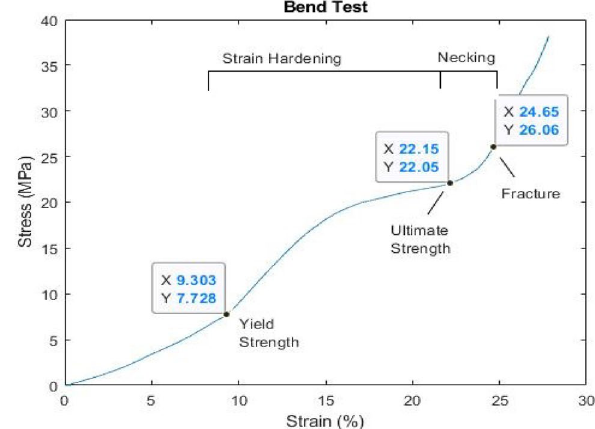
Fig. 15 Tensile strength of device in horizontal axis